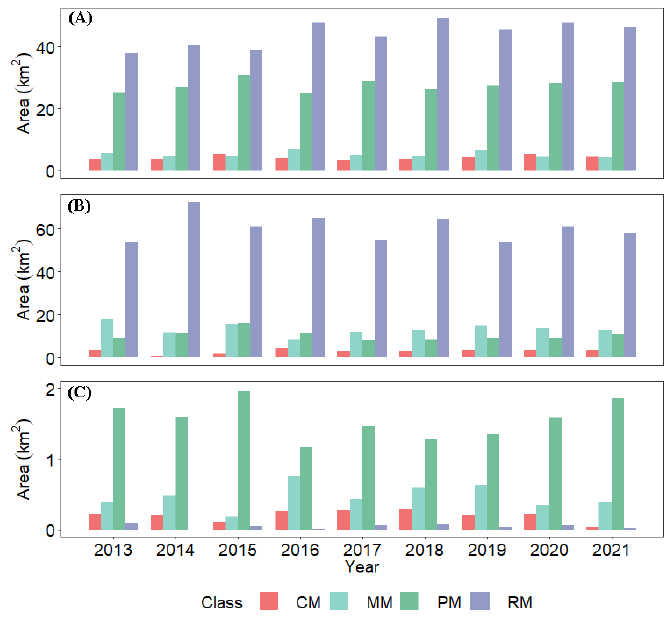
Figure A7. Pixel-scale change frequency of different mariculture types from 2013 to 2021.